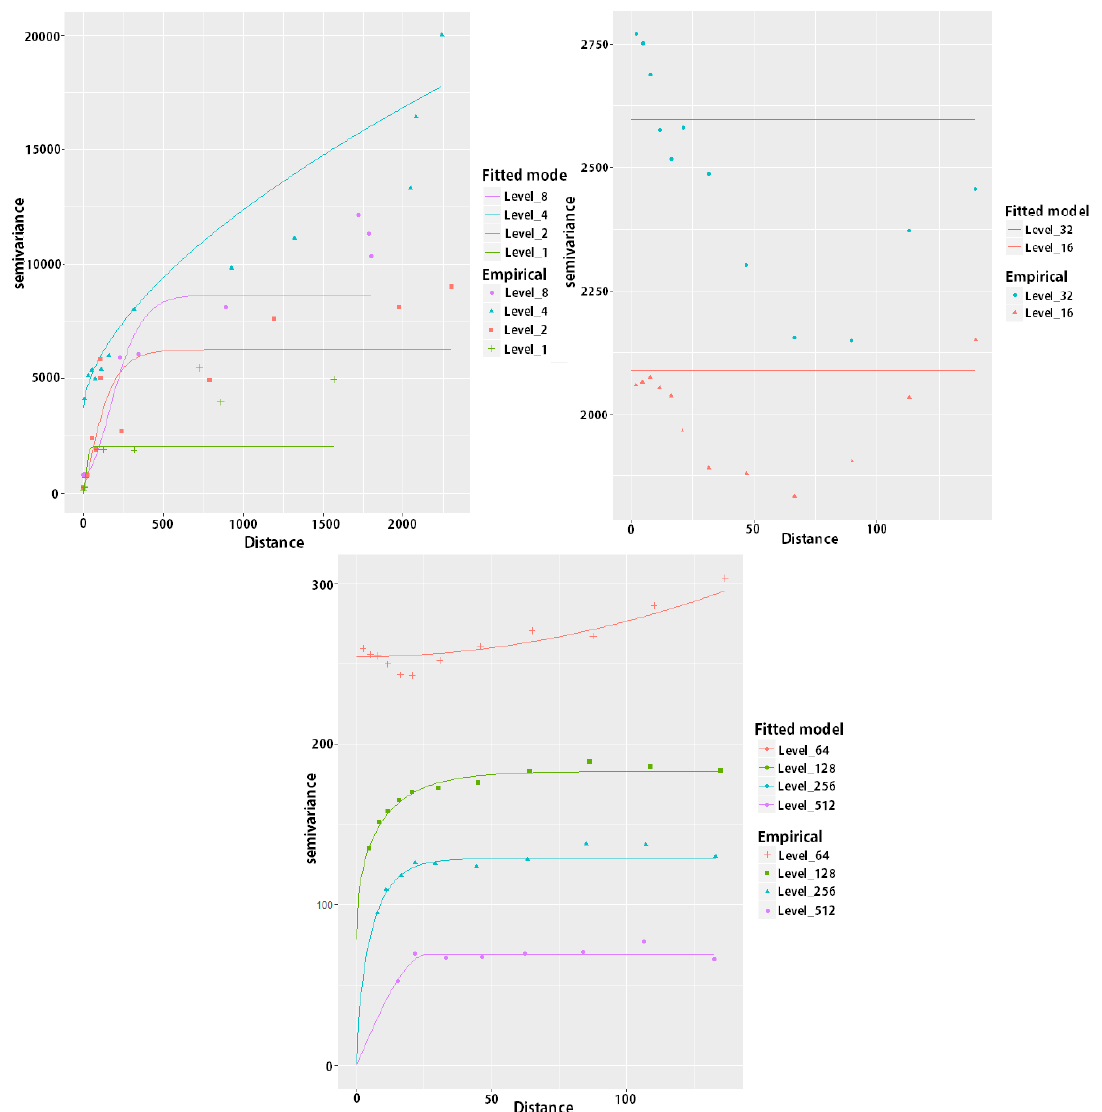
Figure 7. Empirical variogram models across various spatial resolutions.